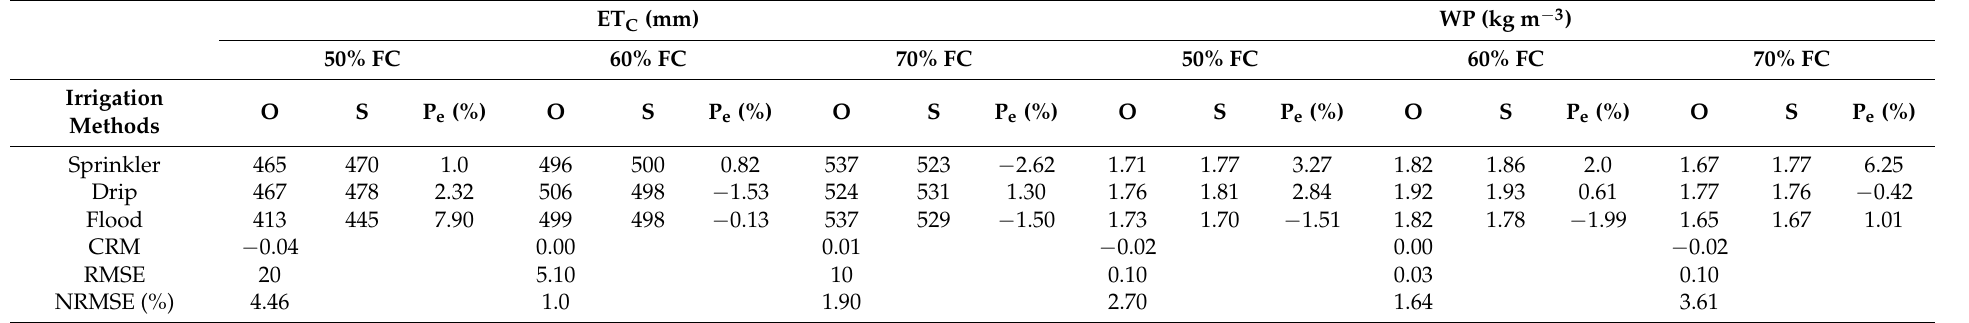
Table 12. Validation results of crop evapotranspiration (ET C ) and water productivity (WP) in 2017 −